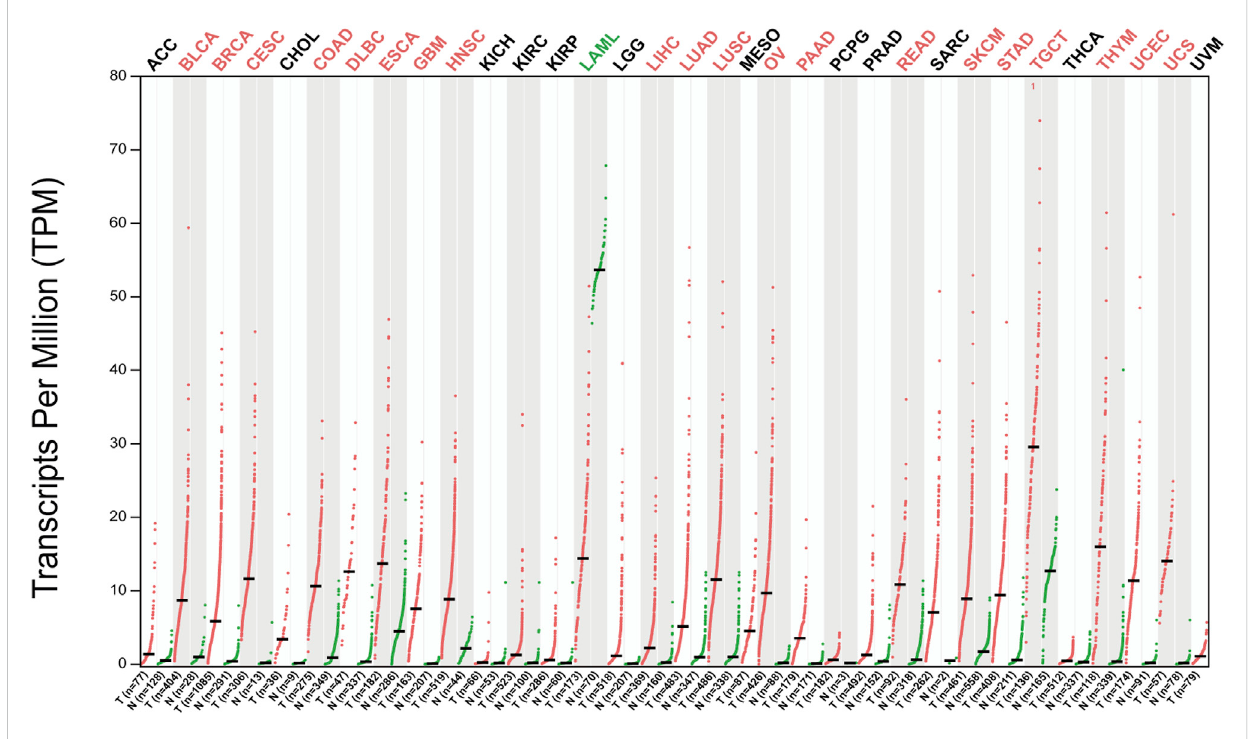
FIGURE 2 Expression patterns of HJURP in pan-cancer. The expression level of HJURP of difffferent tumor types in the GEPIA database (|Log2Fold Change| > 1 and p < 0.01). Red indicates HJURP high expression in tumor tissues and green indicates HJURP high expression in normal